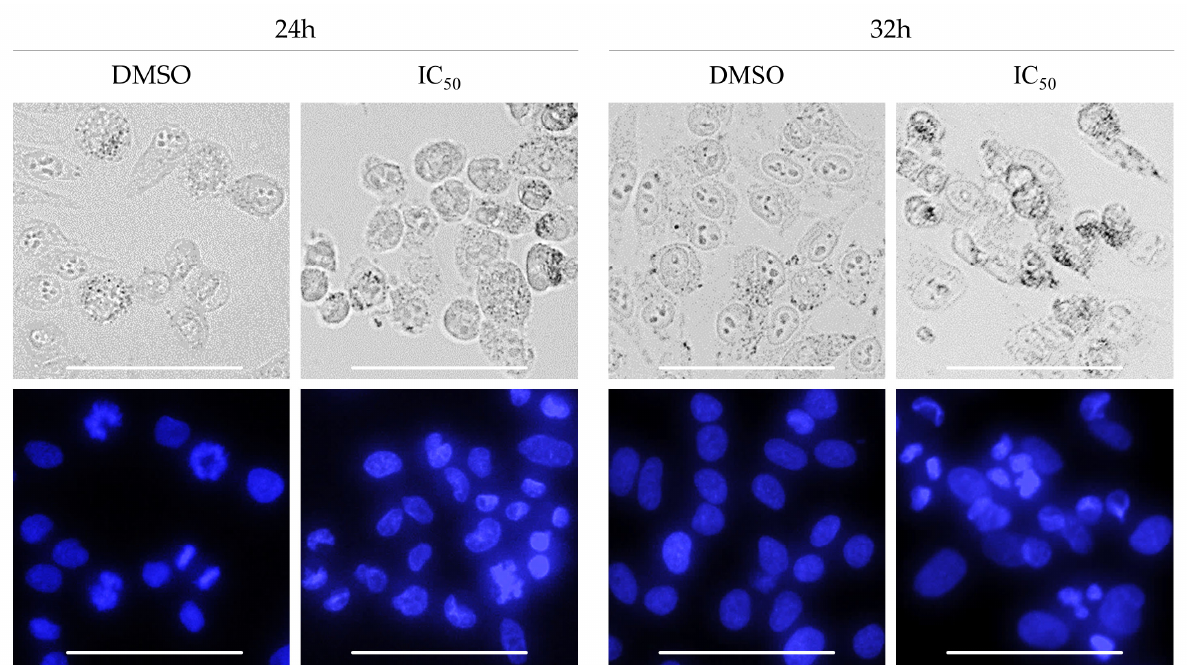
Figure 15. Morphological analysis of HeLa cells stained with DAPI fluorescent dye incubated with or without rinderol. Features of advanced apoptotic cell death (chromatin condensation and occurrence of apoptotic bodies) were observed after 24 h of incubation with investigated compound in 24 h IC 50 concentration (5.66 μ g/mL, DMSO–0.4%). Scale bar: 100 μ m.